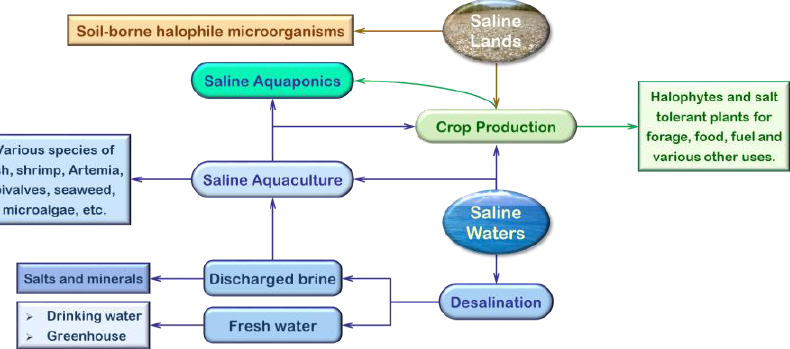
Figure 1. Haloculture concept for the sustainable and integrated use of saline resources [1].